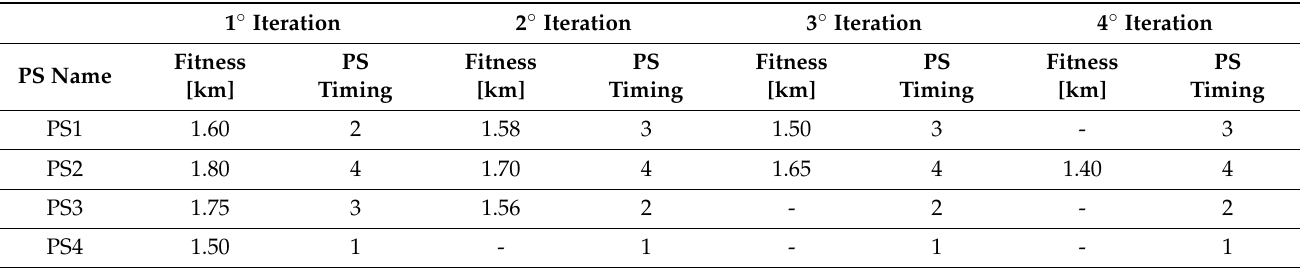
Table 3. Example of the PSs timing process.